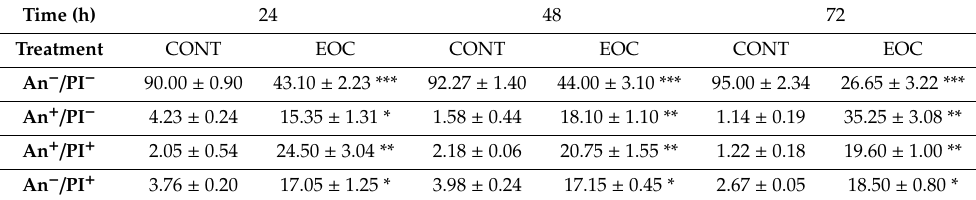
Table 7. Induction of apoptosis in MDA-MB-231 cells after EOC treatment.